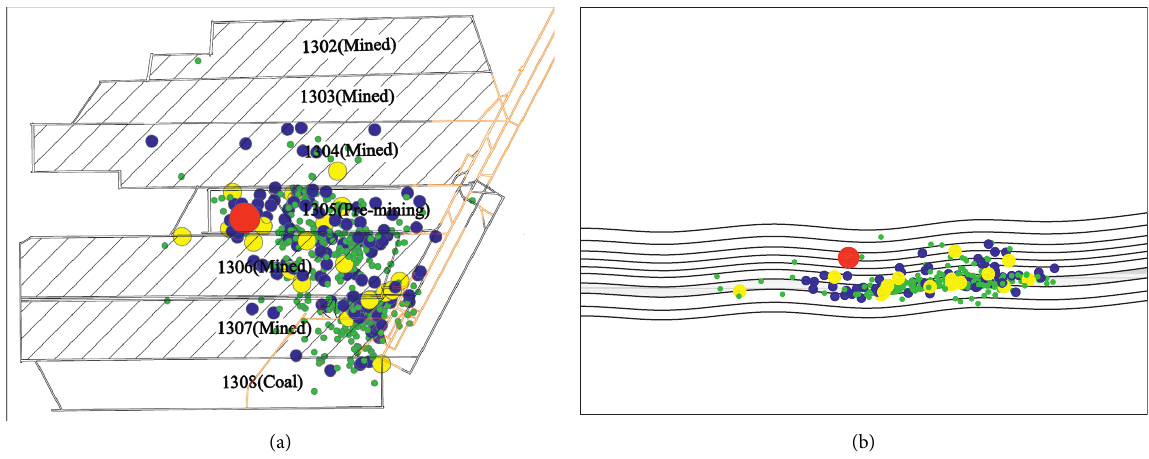
Figure 2: Hypocenter distribution. (a) Plan view. (b) Section view.